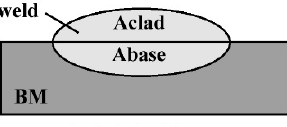
Table 3. The results of the hardness HV10